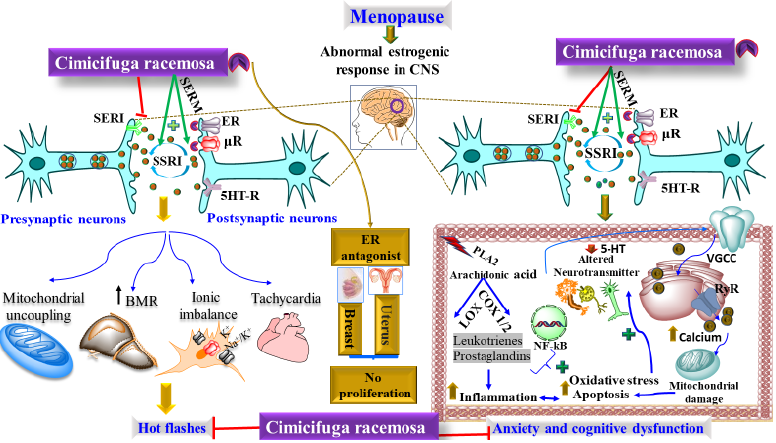
Figure 1. Showing the proposed mechanism of action of CR in menopause-related hot flashes, anxiety, and cognitive dysfunction.